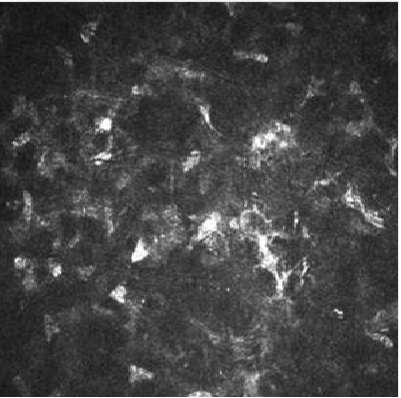
Figure 4. Postoperative haze after laser-assisted subepithelial keratectomy (LASEK).